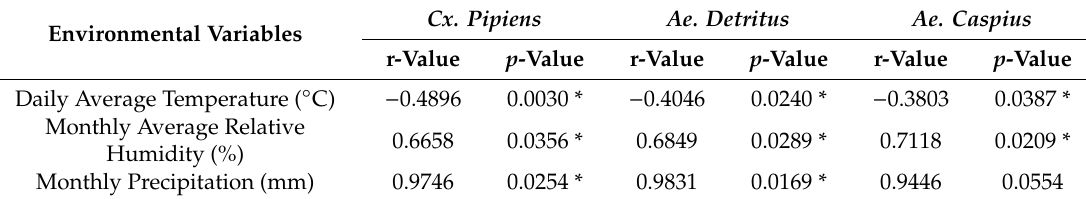
Table 1. Pearson coe ffi cient correlation (r-values) and Multiple linear regression analysis ( p -values) values between numbers of mosquito sampled and daily average temperature, monthly average relative humidity, and monthly precipitation (May 2017–June 2018). Cx. Environmental Variables